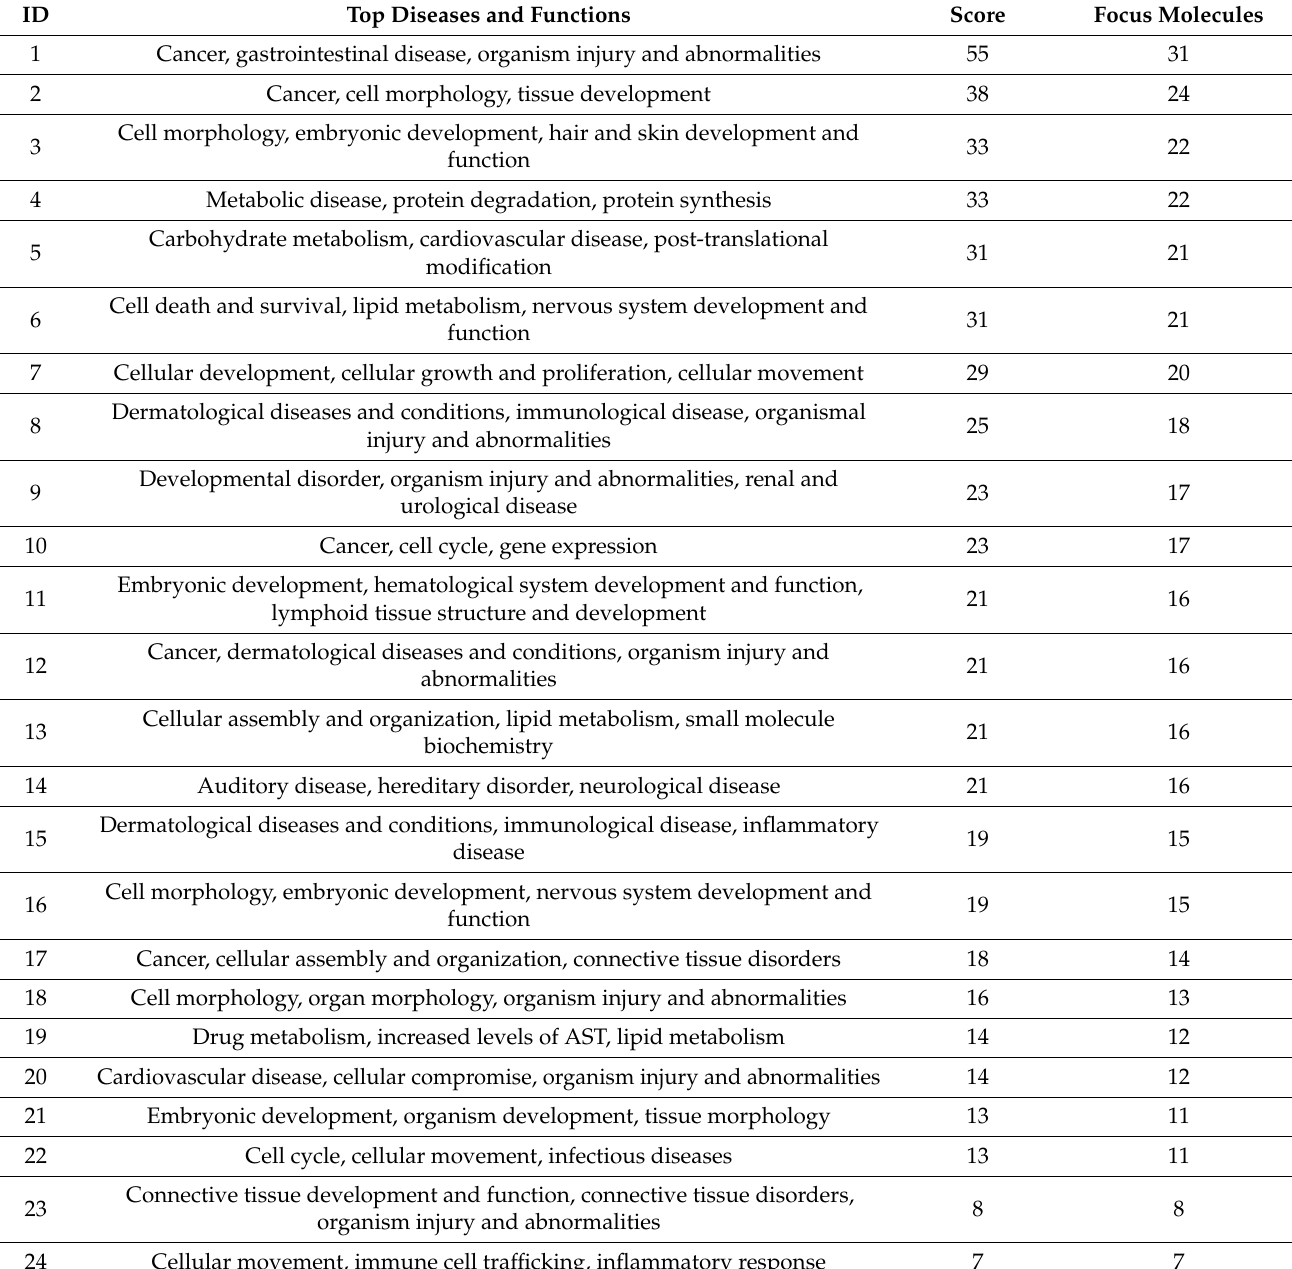
Table 1. The 24 top-ranked networks modulated by